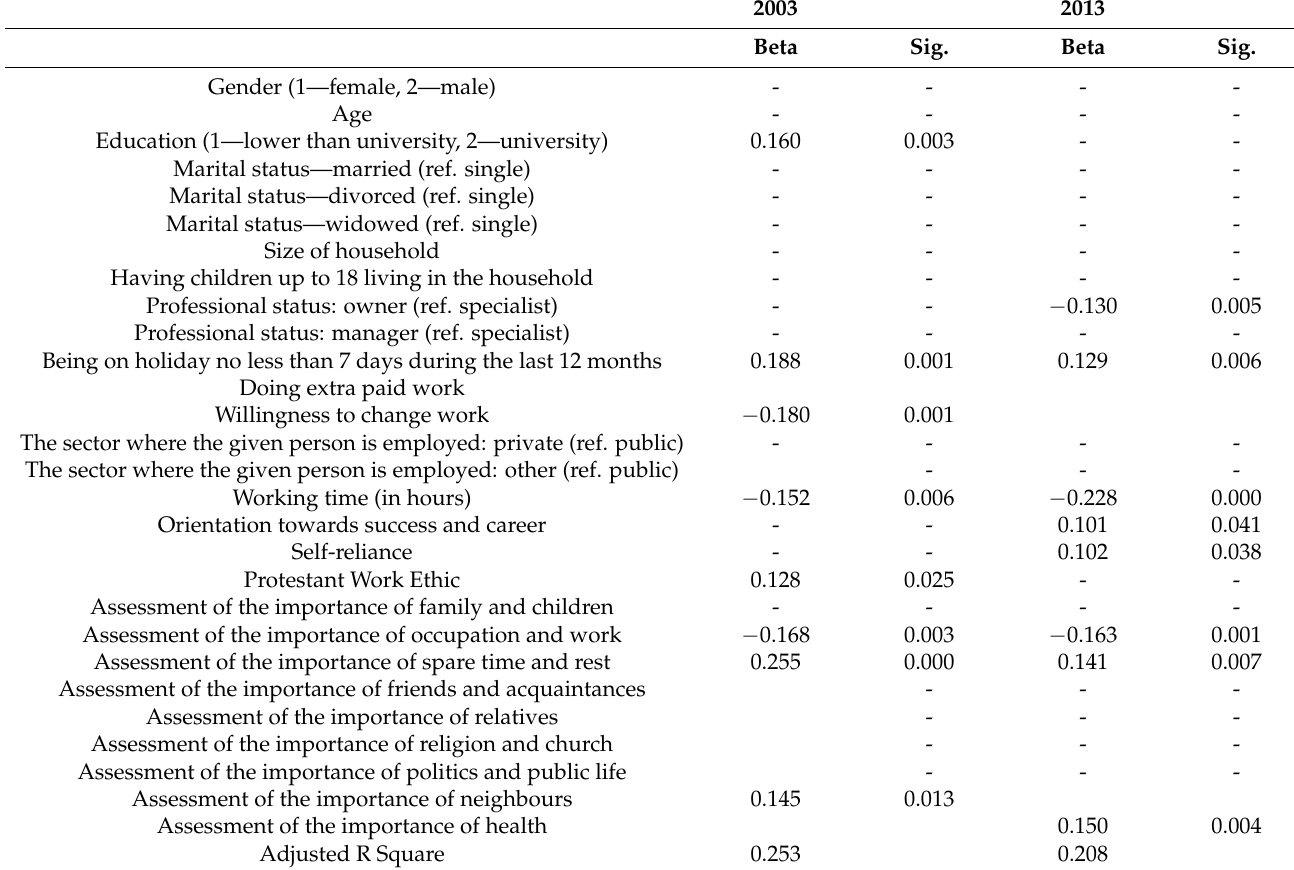
Table 4. Determinants of work–life balance. Results of multiple linear regression